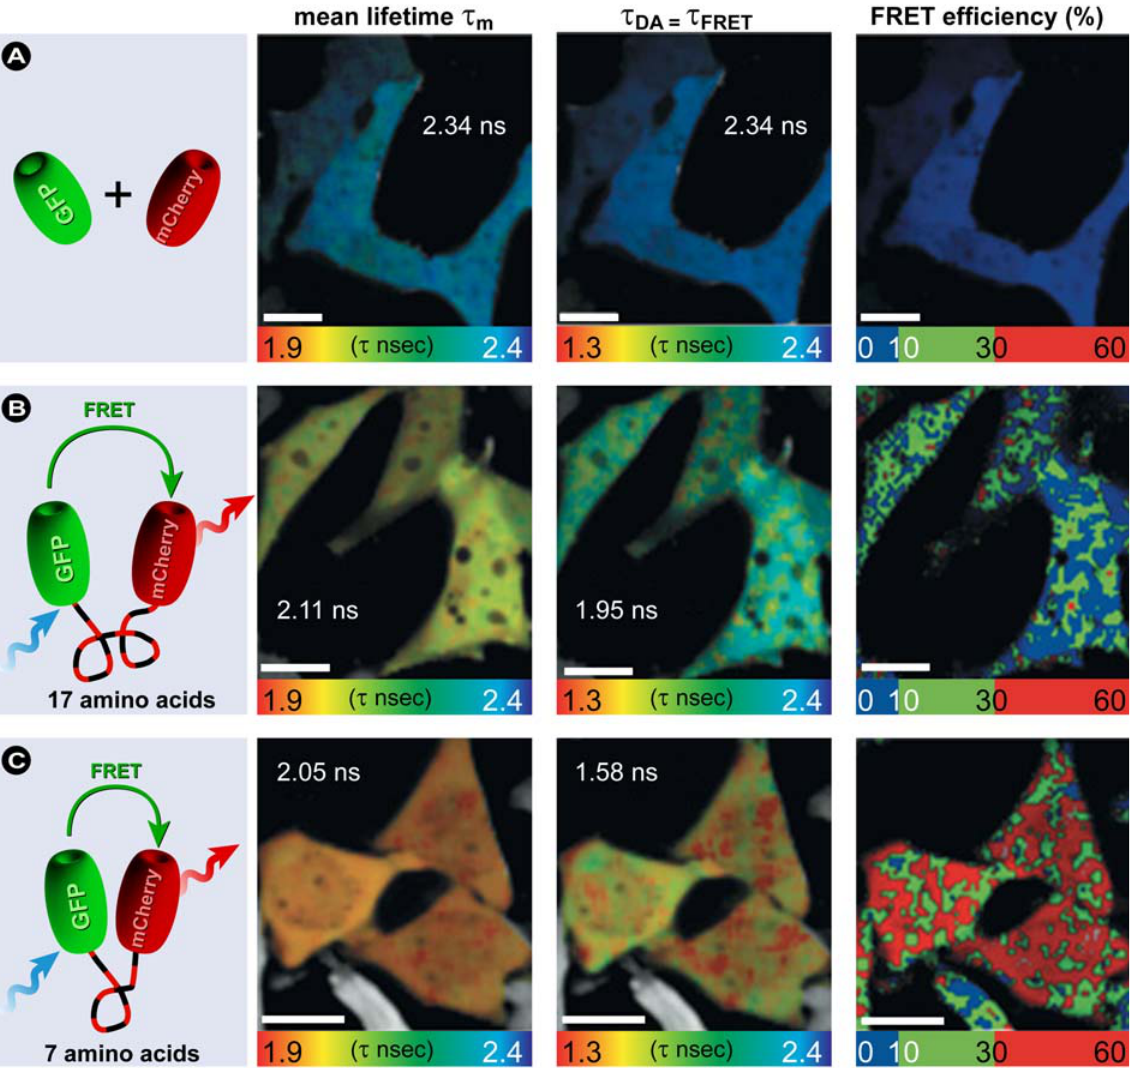
Figure 23. In vivo multiphoton FLIM-FRET measurements. Living HeLa cells co- expressing either unfused, free EGFP and unfused, free mCherry ( A ), or GFP-coupled directly to mCherry through a 17-amino-acid linker ( B ), or GFP-coupled directly to mCherry through a 7-amino-acid linker ( C ) were imaged by using a multiphoton scanning microscope. For each panel, the spatial distribution of the mean fluorescence lifetime ( τ and of the fluorescence lifetime of the donor molecules interacting with the acceptor ( τ is shown throughout the cells. The FRET efficiencies were calculated for each pixel from Eq. 24 × 100%. Color scale shown covers the range of E 10 μ m. Adapted from [217] with permission. © 2007 John Wiley &